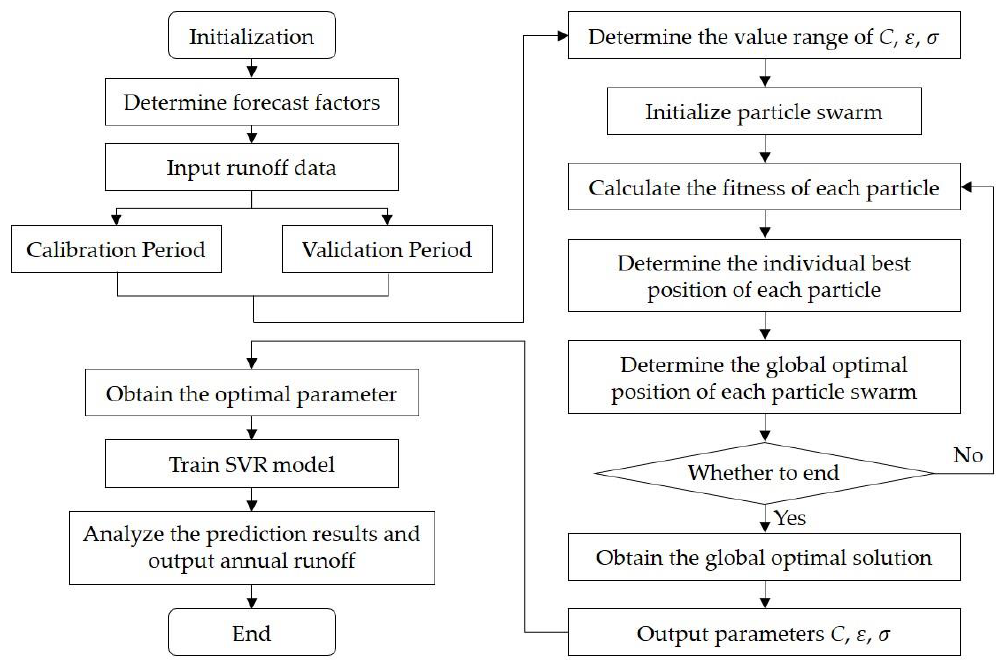
Figure 5. Forecasting process of the particle swarm optimization-regression support vector machine (PSO-SVR) model.